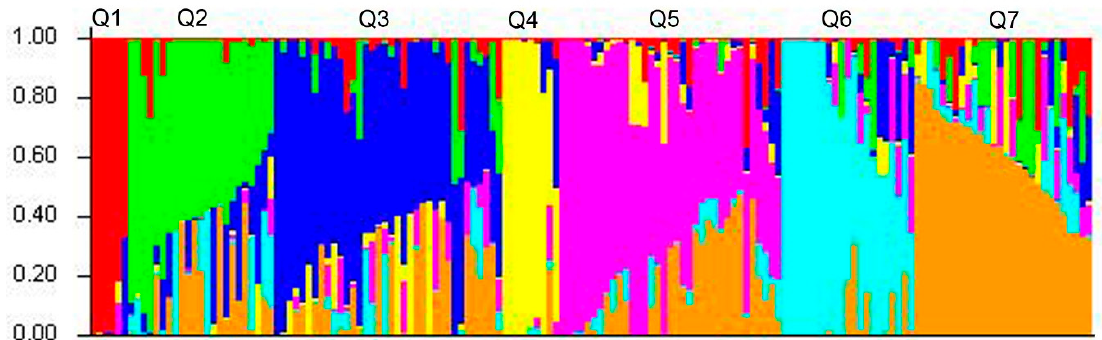
Figure 3. The population structure of spring wheat varieties calculated based on genotyping using 4800 SNP markers. The list of the genotypes belonging to the individual subpopulation is presented in Table S2.